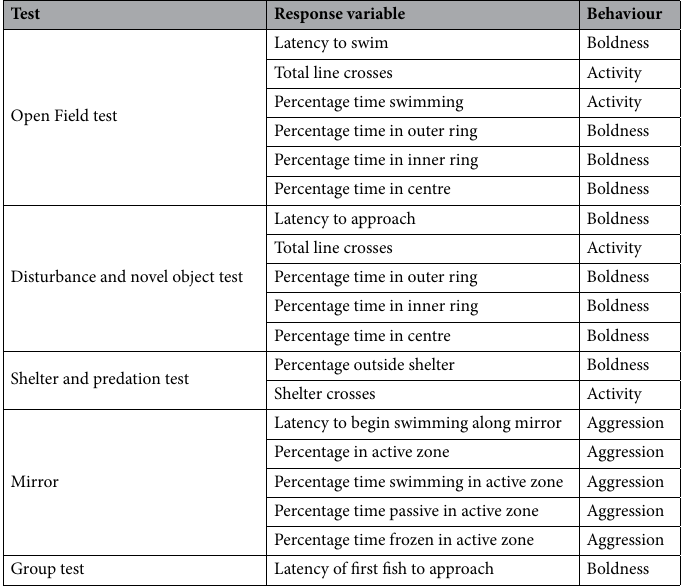
Table 2. List of response variables from each of the behaviour tests, and the behavioural descriptors for each